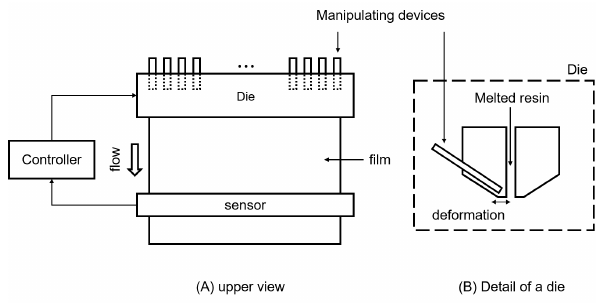
Figure 1. Schematic drawing of the film fabrication